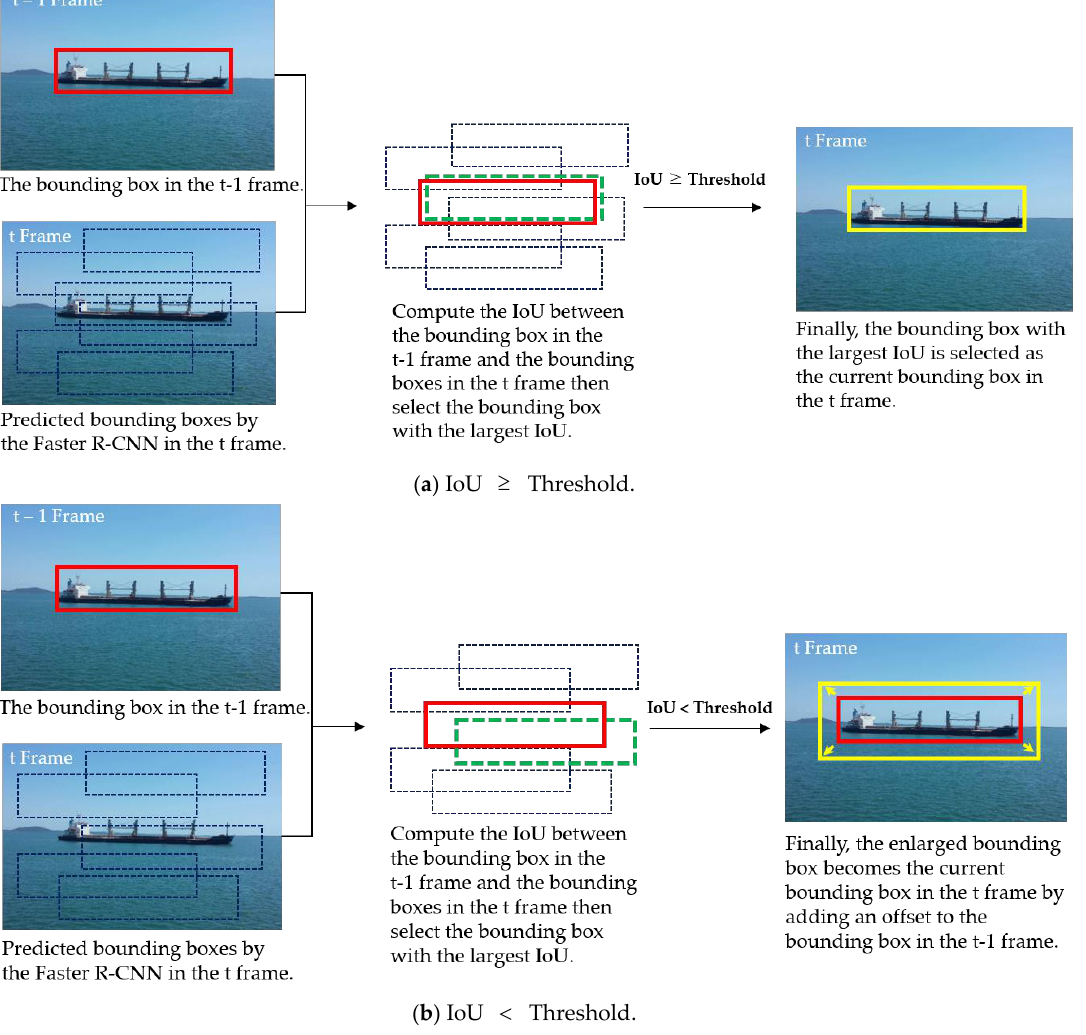
Figure 3. IoU tracking. ( a ) IoU is equal to or larger than the threshold and ( b ) IoU is less than the threshold. If IoU is less than the threshold, the bounding box in frame t − 1 increases slightly and is updated as the target ship-bounding box to avoid missing ship detection.